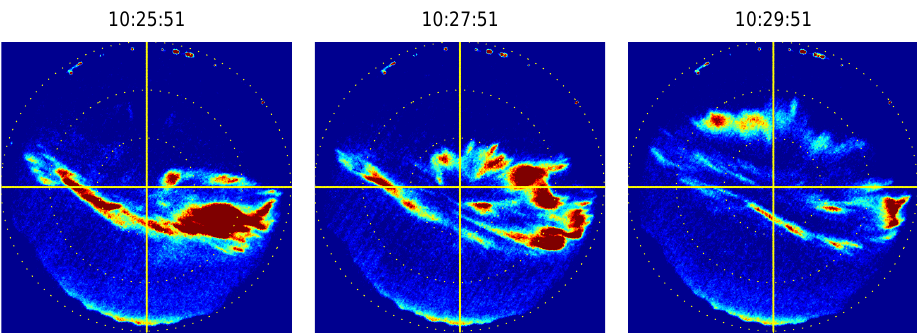
Figure 7 Fig. 7. Ny ˚Alesund ASC observations at 557.7nm for the interval 10:25–10:19 UT on 3 December 1997. Same format as in Fig. 4.